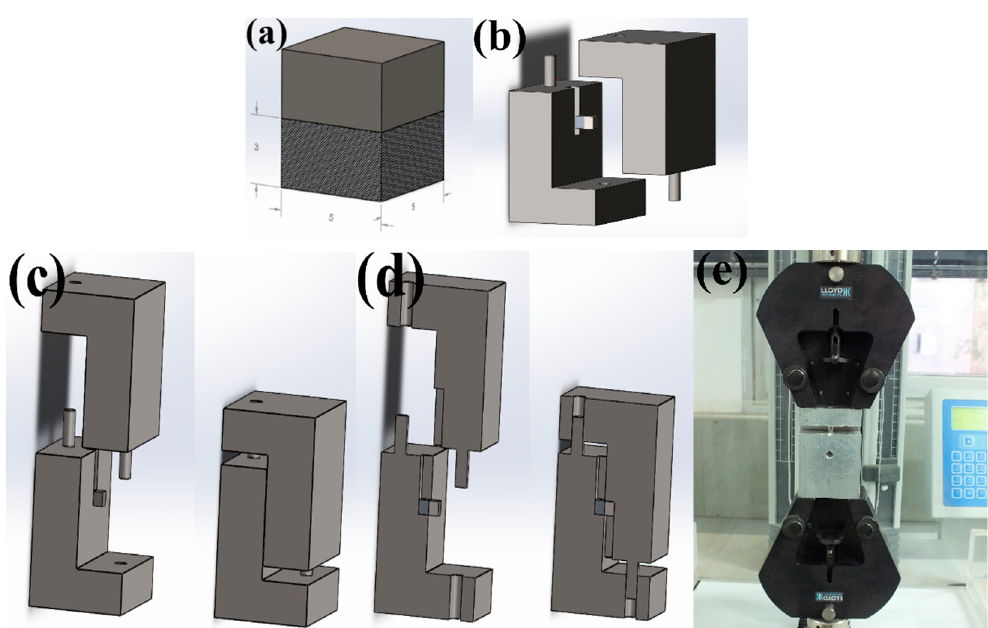
Figure 9. Shear test tools and specimen. ( a ) Test specimen, dimensions 5 × 5 × 6 mm 3 ; ( b ) test tools and specimen; ( c ) test tools and specimen before and after mounting, full views; ( d ) test tools and specimen before and after mounting, cross-section views; ( e ) testing apparatus with mounted tools.